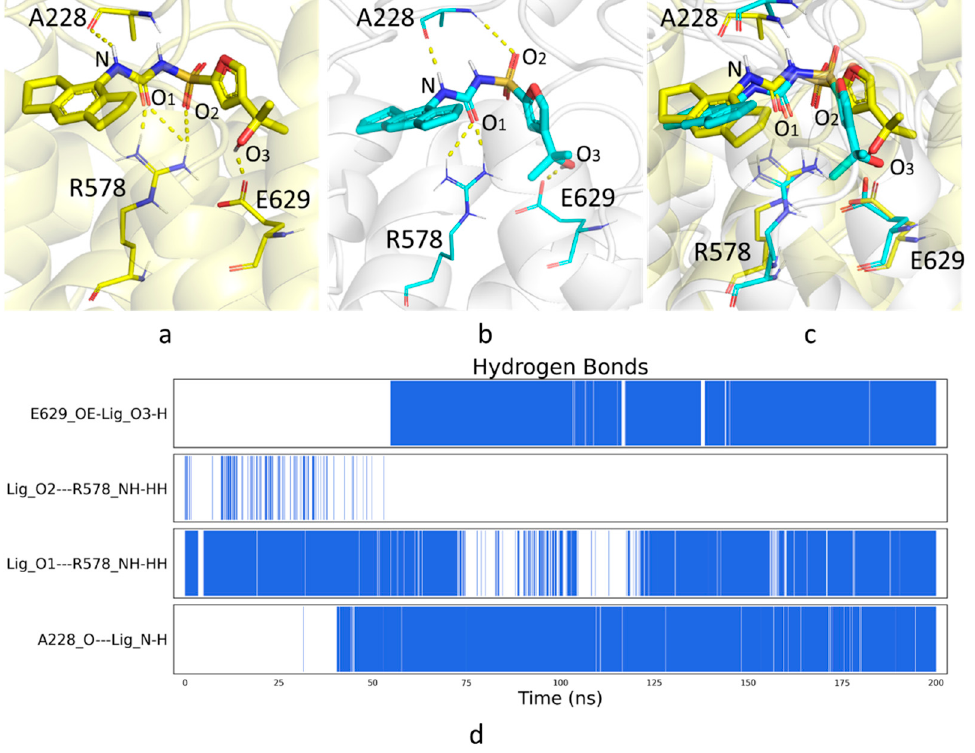
Figure 6. Binding modes of MCC950 in ( a ) 7PZC and ( b ) AF model 4 in complex with ADP and MCC950 from the last frame of the 200 ns MD simulations; ( c ) structural overlay of ( a , b ); ( d ) hydrogen bond analysis of the MD simulations.